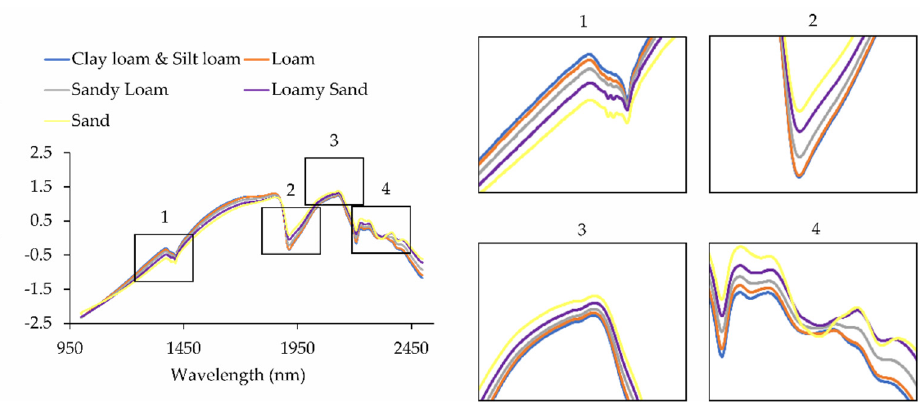
Figure 5. Spatial distribution maps of soil properties that showed spatial variability.